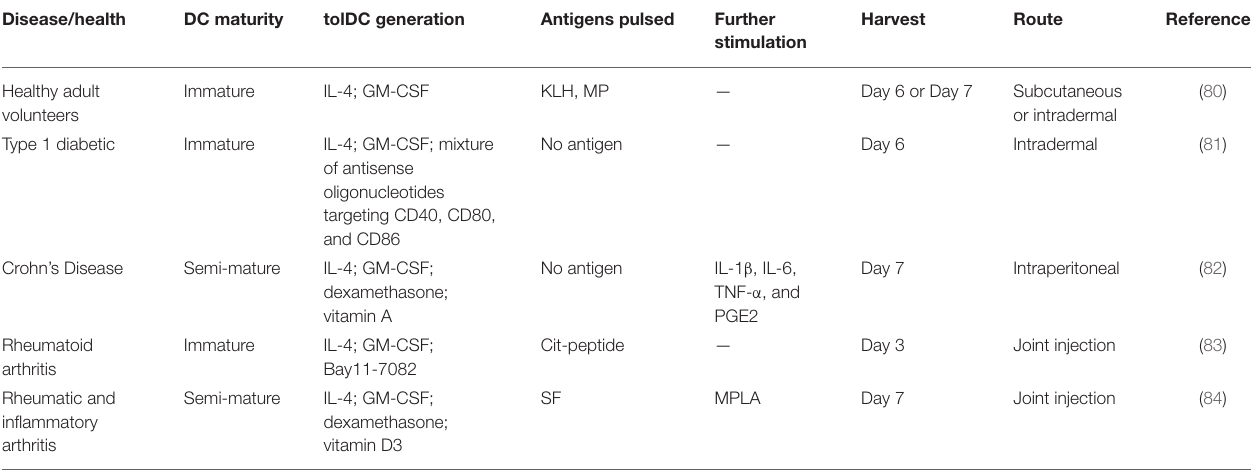
TABLE 1 | Tolerogenic dendritic cell (tolDC)-inducing protocols.